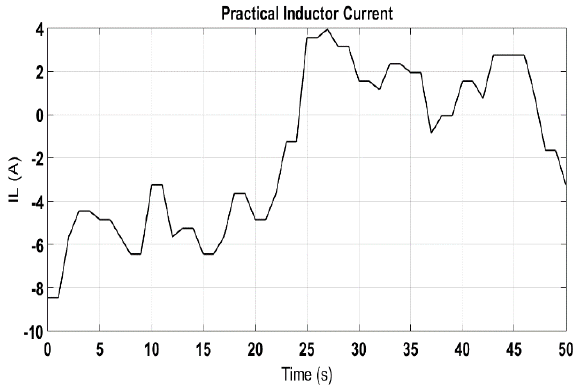
Figure 10. AC part of measured inductor current.